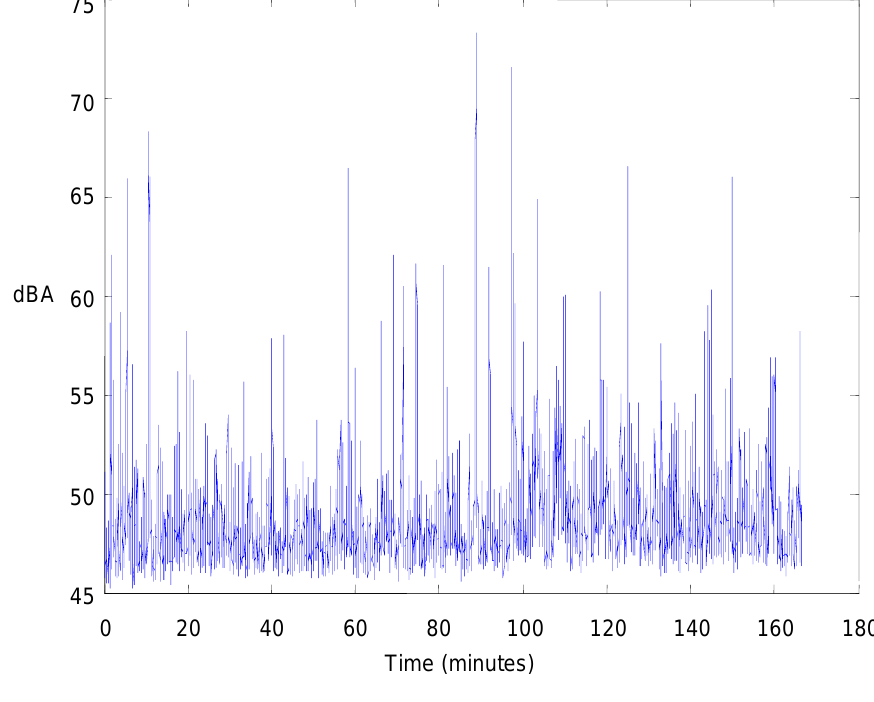
Figure 7. A-weighting equivalent noise level values measured by the sensor